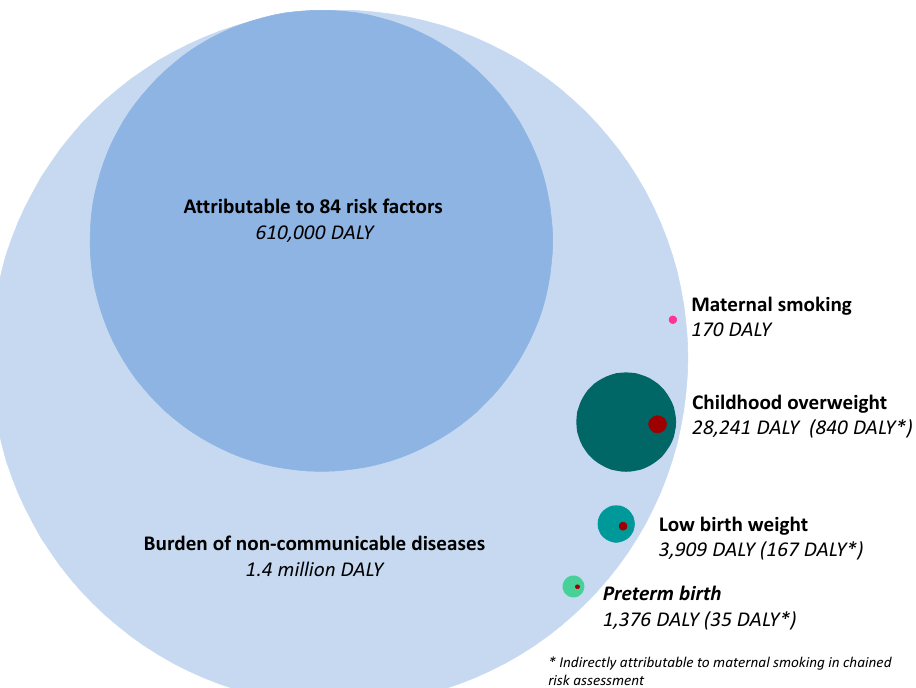
Figure 4. Bubble plot indicating the total burden of disease in Finland in light blue (2017) with the attributable fractions due to risk factors included in the Global Burden of Disease Study (blue), and maternal smoking (direct burden in pink, indirect burden in dark red) and intermediate risk factors considered in this work (green shades). Based on data from [2].